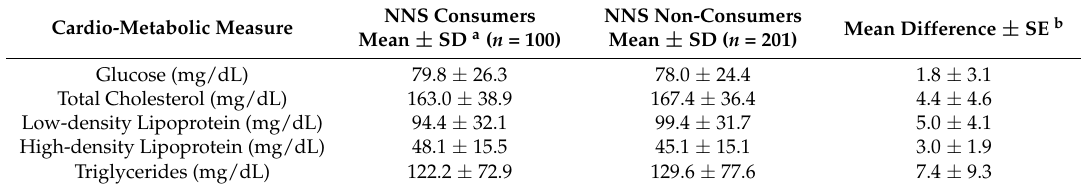
Table 4. Cardio-metabolic measures for non-nutritive sweetener (NNS) consumers versus NNS non-consumers. Cardio-Metabolic Measure